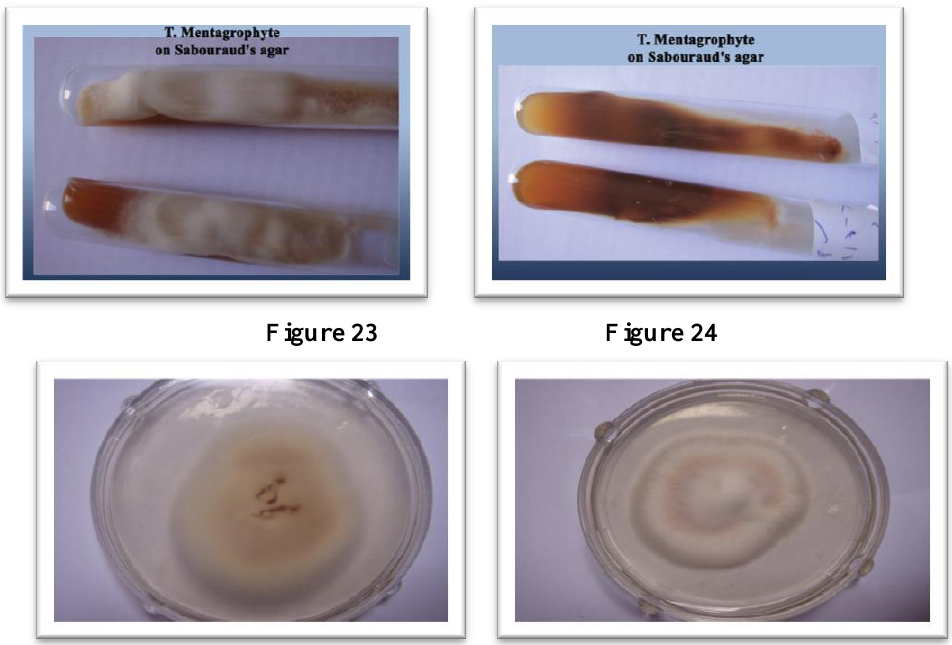
Figure26 :T. Mentagrophyte on Sabouraud's aga